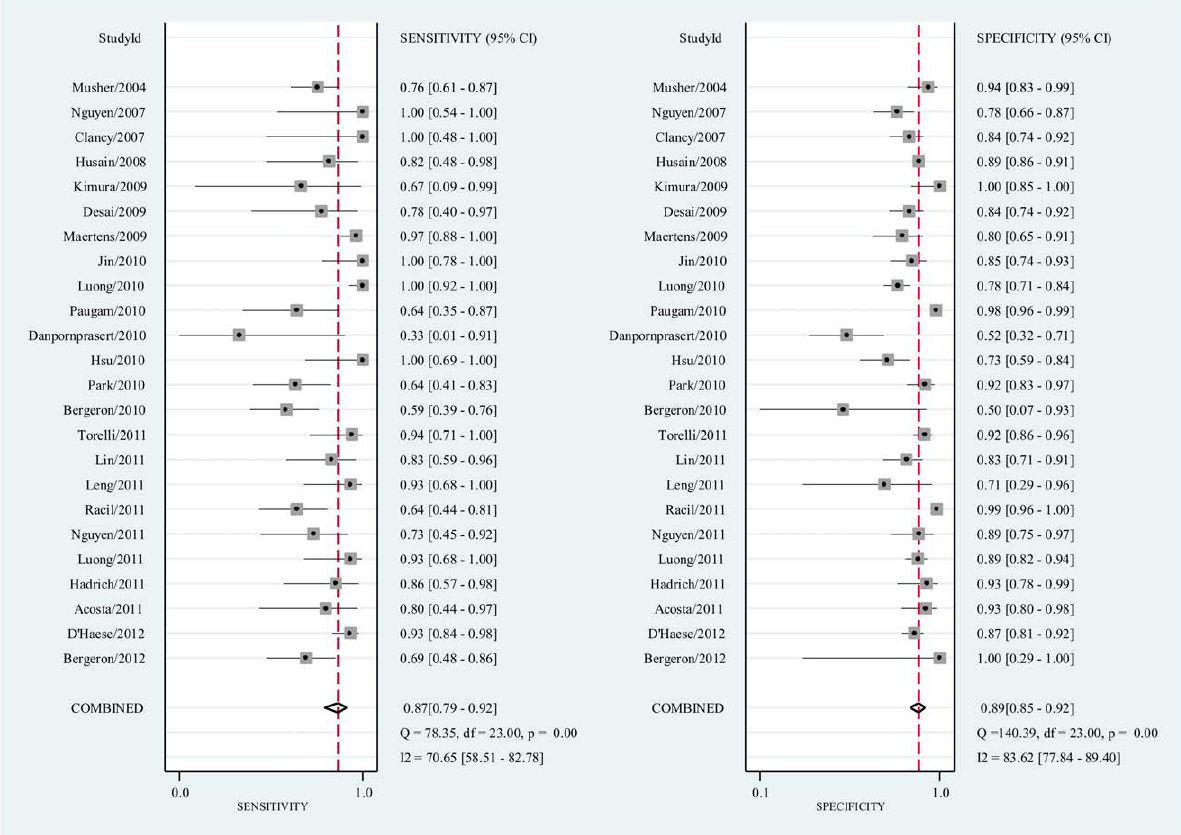
Figure 3. Forest plot of sensitivities and specificities from test accuracy studies of BAL-GM in the diagnosis of IA.